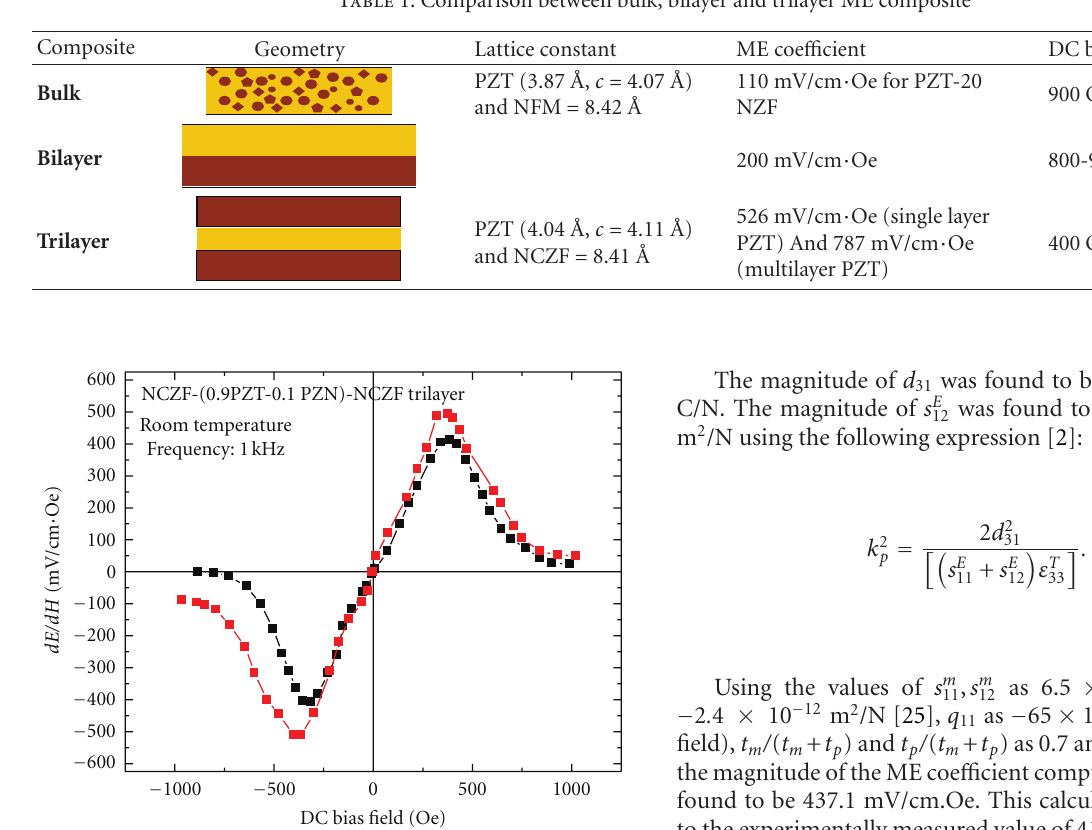
Table 1: Comparison between bulk, bilayer and trilayer ME composite